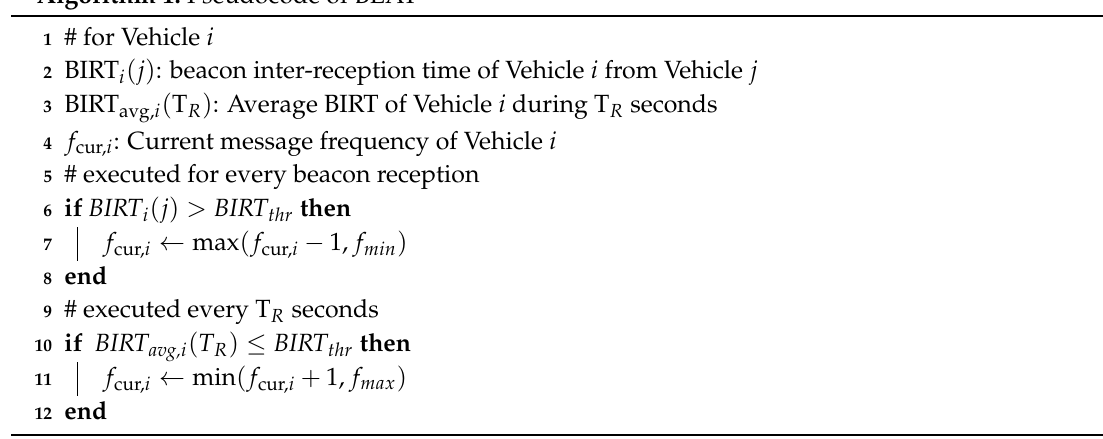
Algorithm 1: Pseudocode of